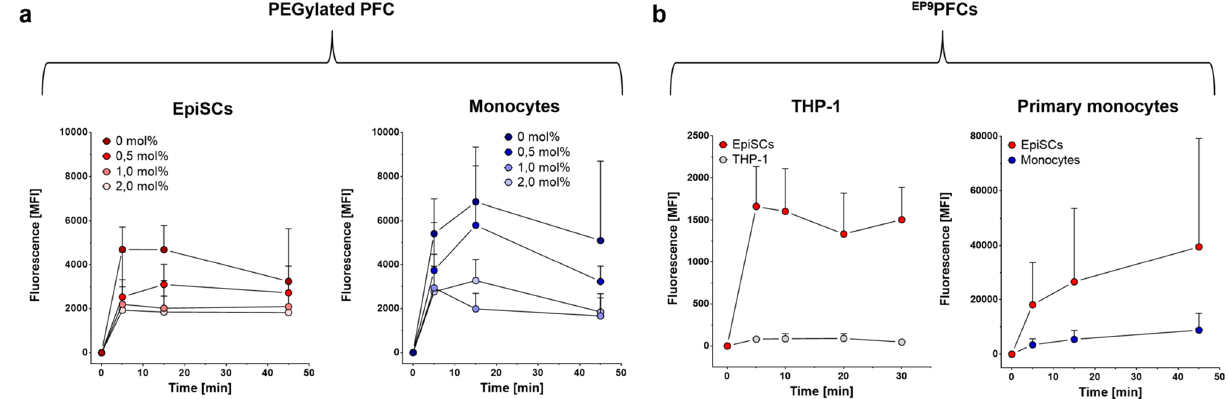
Figure 5. ( a ) Cellular uptake of PFCs with increasing amounts of PEGylation by EpiSCs and human primary monocytes. Cultivated EpiSCs and human primary CD14 + monocytes were incubated with Cy5 PFCs (0 µg cholesterol-PEG 2000 = chol-PEG) and Cy5 PFCs which were modified with 0.5 mol%, 1 mol% and 2 mol% chol- PEG (referred to the total lipid content) over a period of 45 min at 37 °C. At distinct time points (0, 5, 15 and 45 min), the cells were analyzed by flow cytometry. Data show the Cy5 mean fluorescence intensity (MFI) of the cells ± SD of n = 3 experiments. ( b ) Competition of EpiSCs and THP-1 (left) or primary monocytes (right) for EP9 PFC uptake: Left: EpiSCs and THP-1 monocytes were incubated with EP9 PFCs (based on Mal PFCs) over a period of 30 min at 37 °C. At distinct time points (0, 5, 10, 20 and 30 min), samples were analyzed by flow cytometry. Right: Cellular uptake of EP9 PFCs (generated by sterol-based post-insertion) by EpiSCs and human primary monocytes. Cells were incubated with EP9 PFCs over a period of 45 min at 37 °C and analysed after 0, 5, 15 and 45 min by flow cytometry. Data are shown as mean fluorescence intensity (MFI) ± SD of n =